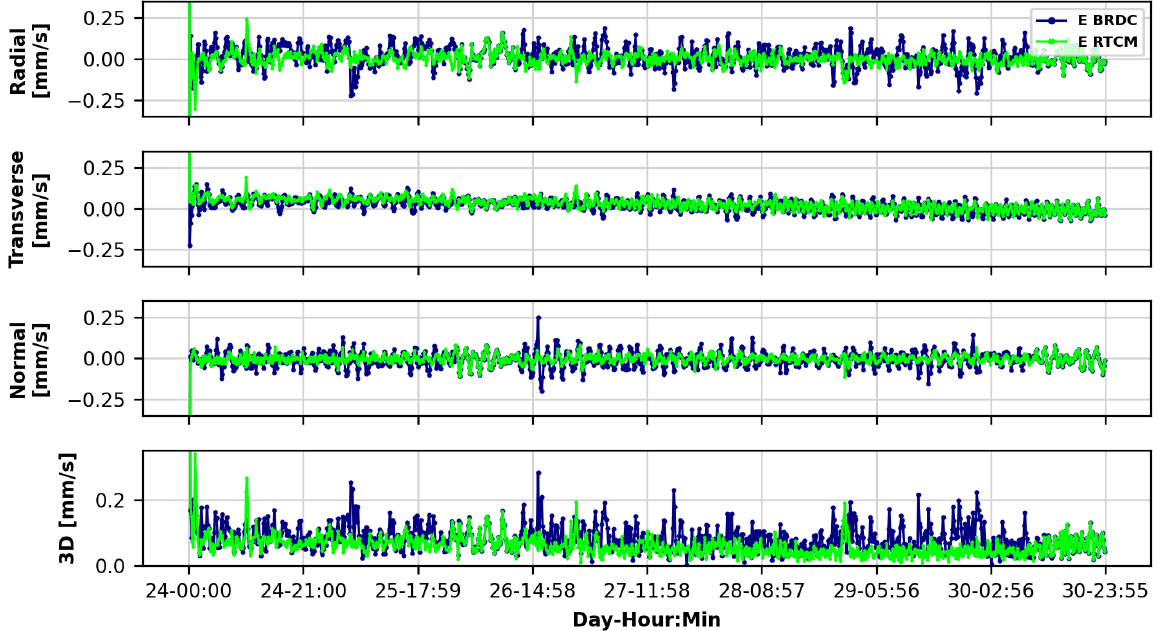
Figure 4. S6A velocity difference with respect to CNES-POD reference solution from 24 September to 30 September 2021. Two solutions are compared: one is obtained using only broadcast navigation data (blue-colored lines), and the other is found by correcting the broadcast navigation data using RTCM corrections from CNES (green-colored lines).